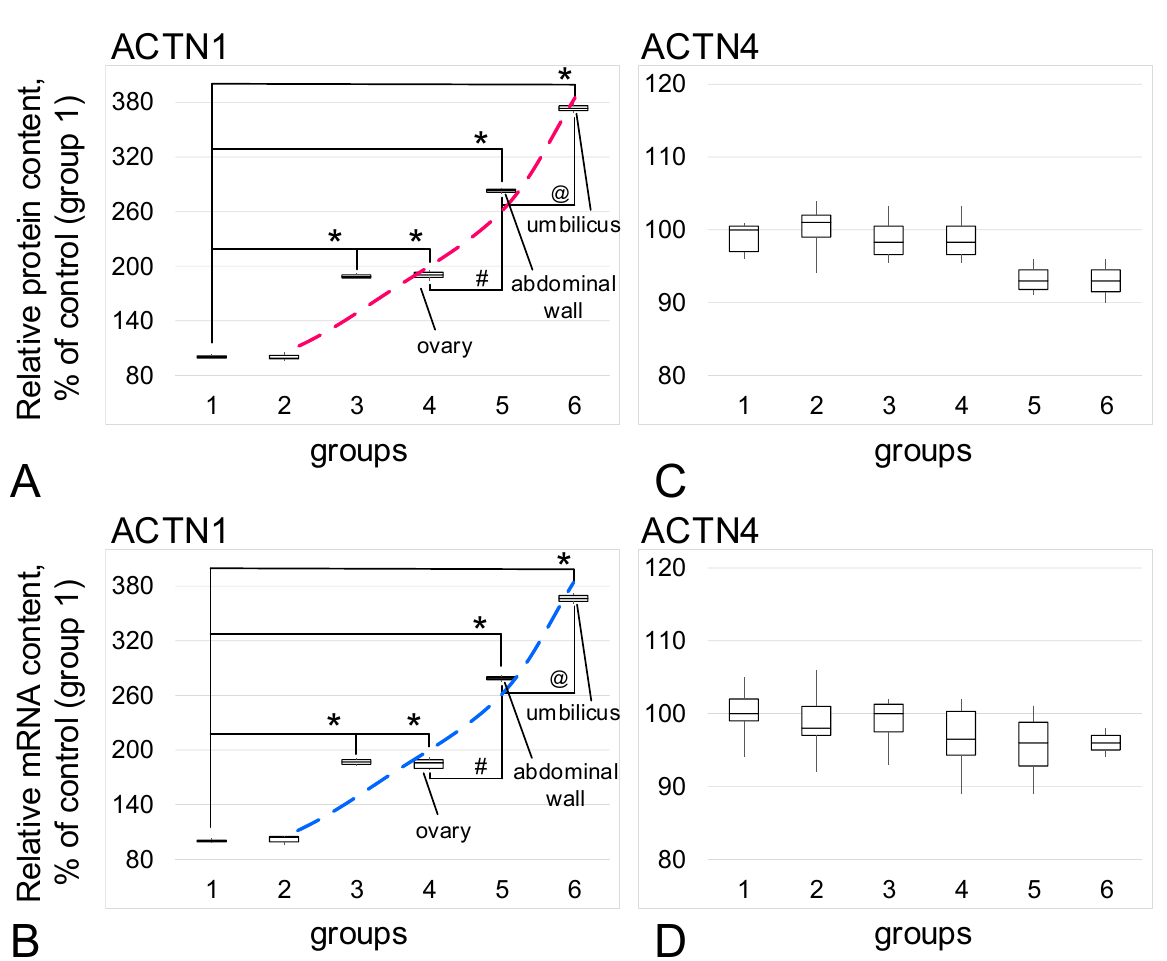
Figure 3. Relative content of alpha-actinin isoforms and their mRNA. ( A )—Alpha-actinin1 (ACTN1) protein. ( B )—Alpha-actinin1 mRNA. ( C )—Alpha-actinin4 (ACTN4) protein. ( D )—Alpha-actinin4 mRNA. *— p < 0.05 in comparison with control group 1 (women in postmenopause without endometriosis in their anamnesis). #— p < 0.05 in comparison with group 4 (women with genital endometriosis). @— p < 0.05 in comparison with group 5 (women with extragenital endometriosis, but localized in the small pelvis). Red and blue dashed lines reflect trends in protein and mRNA content, respectively. Group designations are the same as above.